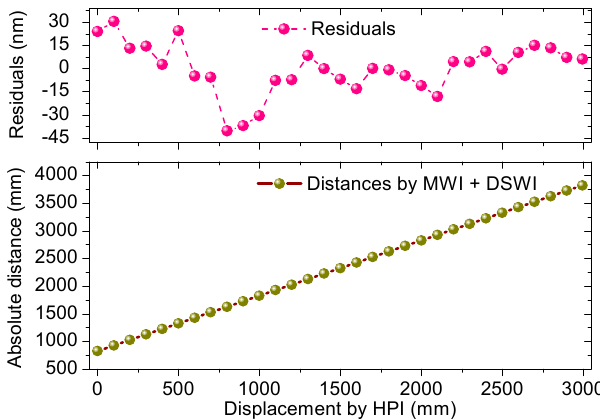
Figure 6. Linear comparison of the ADM interferometer with the He–Ne laser interferometer over a 3.0 m axis distance.